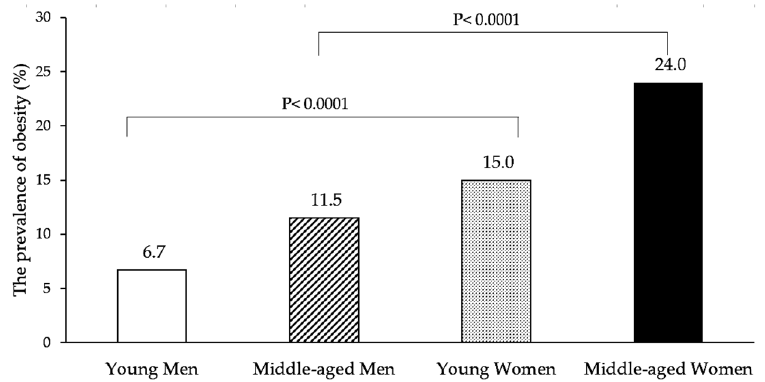
Figure 1. The prevalence of obesity (BMI ≥ 27.5 kg/m 2 ) among Indonesian adults.